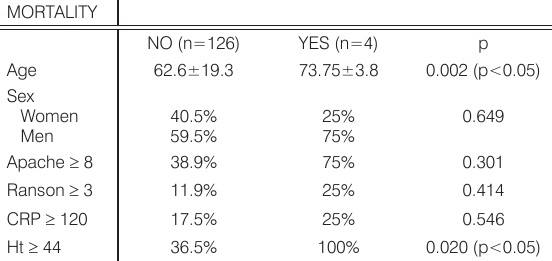
Table 3. Univariate analysis regarding mortality.